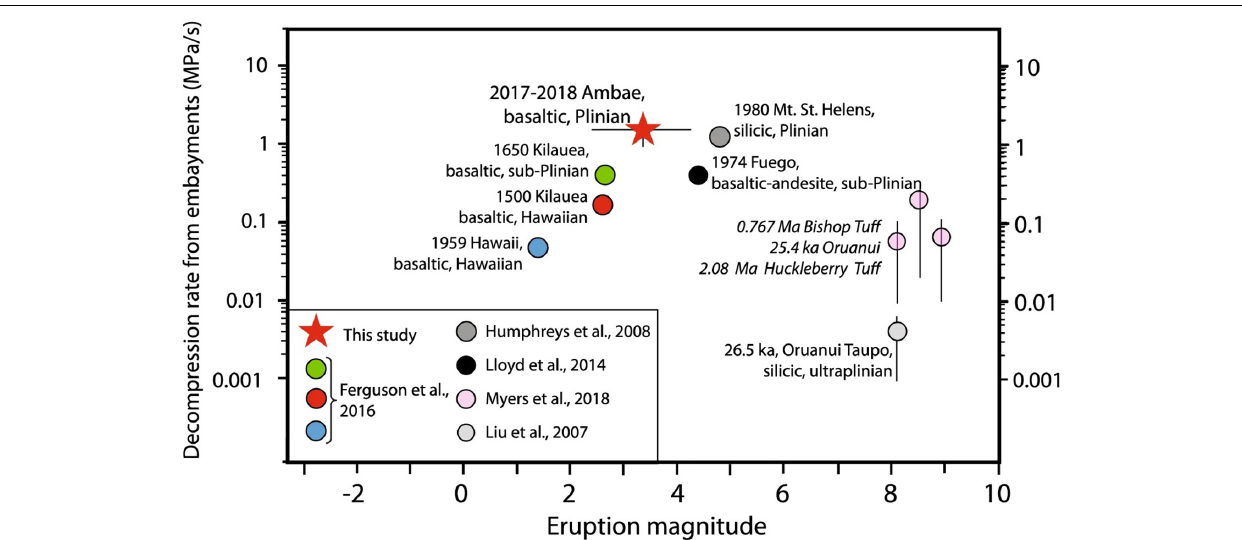
FIGURE 6 | From Moussallam et al. (2019), their Figure 13. Compilation of decompression rate estimates using the embayment volatile diffusion method and comparison with eruption magnitude. For basaltic eruptions a trend of increasing decompression rate (i.e., ascent rate) with increasing eruption magnitude can be observed, although this does not extend to more silicic compositions. This trend can be used to approximately estimate decompression rate from eruption magnitude in order to assess water loss (see text for further details). Reprinted by permission from Springer Nature Customer Service Centre GmbH: Springer. Contributions to Mineralogy and Petrology. Moussallam et al. Fast ascent rate during the 2017–2018 Plinian eruption of Ambae (Aoba) volcano: a petrological investigation, copyright